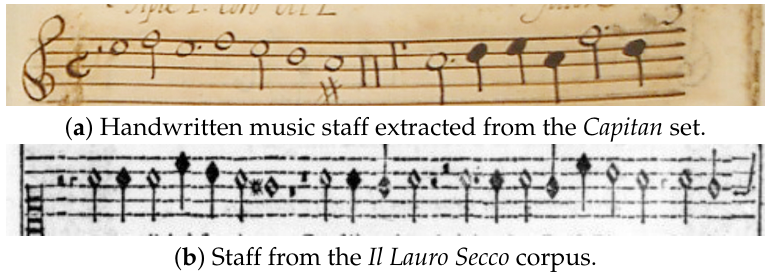
Figure 4. Music excerpts of the two corpora used in the experiments.